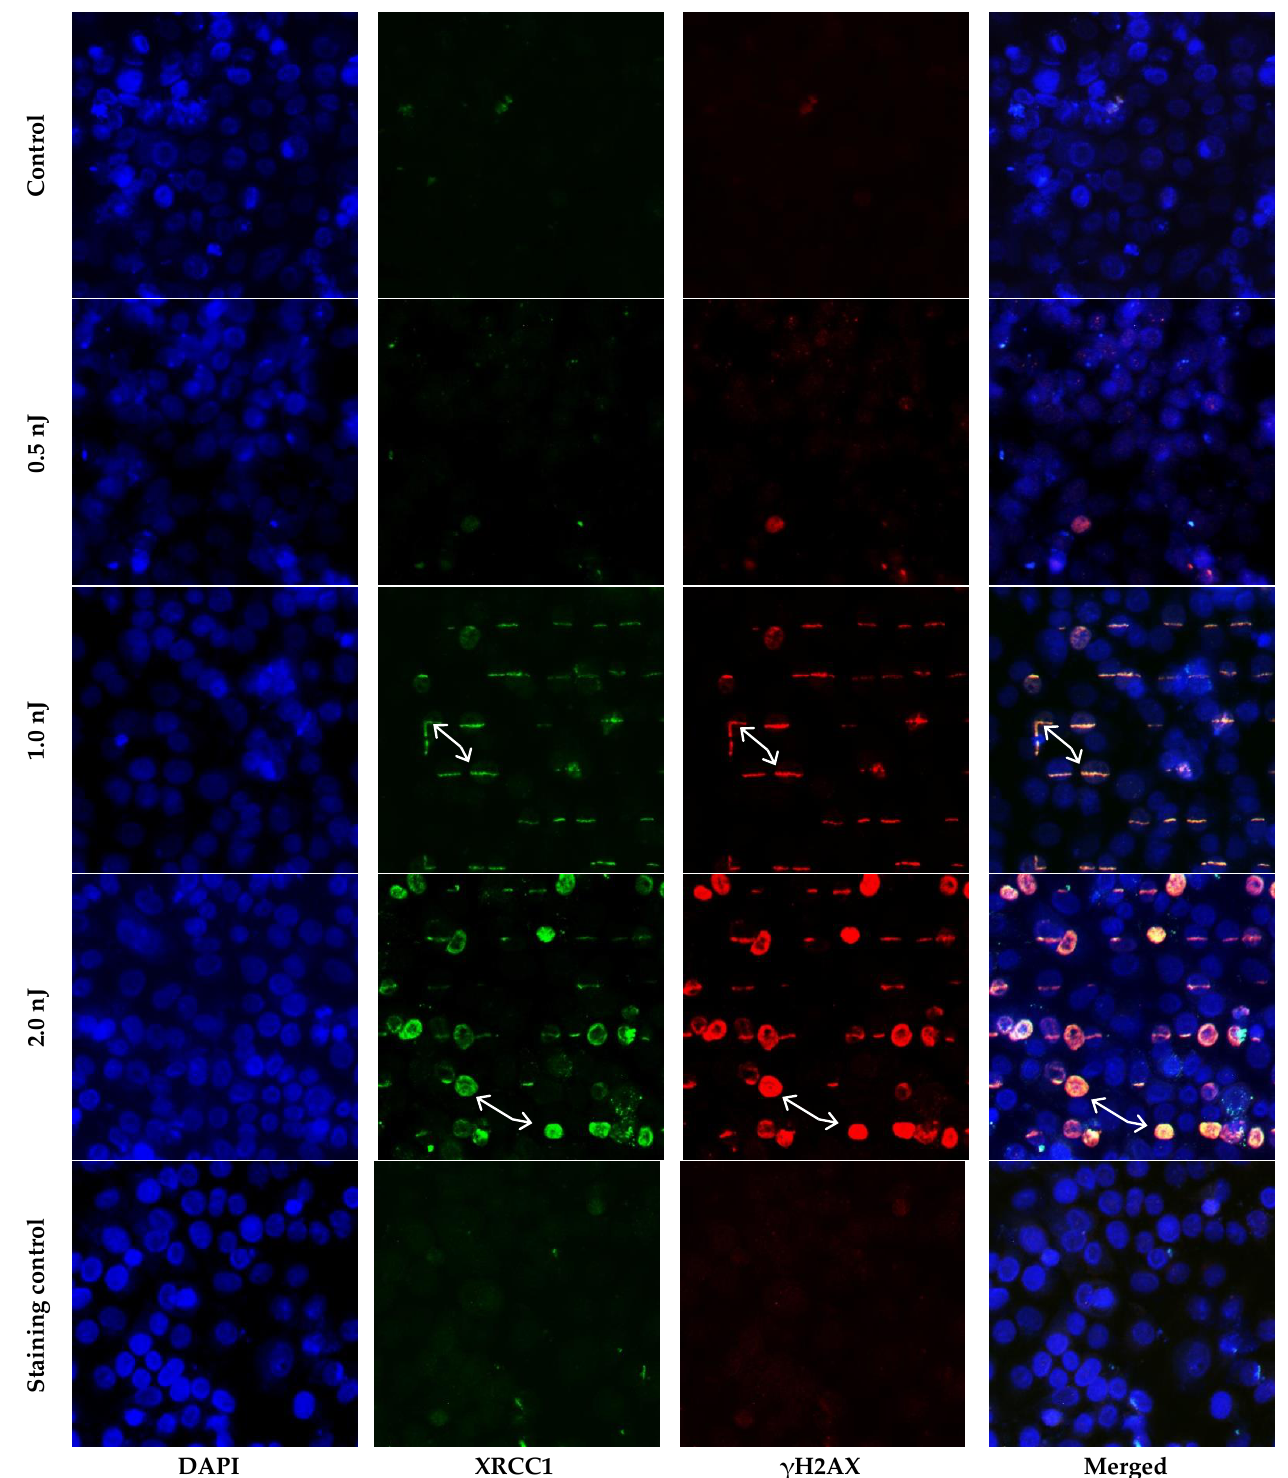
Figure 1. Microscopy image of immunocytochemically stained cell nuclei 30 min after exposure to femtosecond laser radiation with a pulse energy of 0.5 nJ (power density 1 × 10 11 W · cm − 2 ), 1.0 nJ (power density 2 × 10 11 W · cm − 2 ), and 2.0 nJ (power density 4 × 10 11 W · cm − 2 ). Arrows show foci tracks (1.0 nJ) or pan-stained nuclei (2.0 nJ). Staining control cells irradiated with a pulse energy of 2.0 nJ and stained with only secondary antibodies.